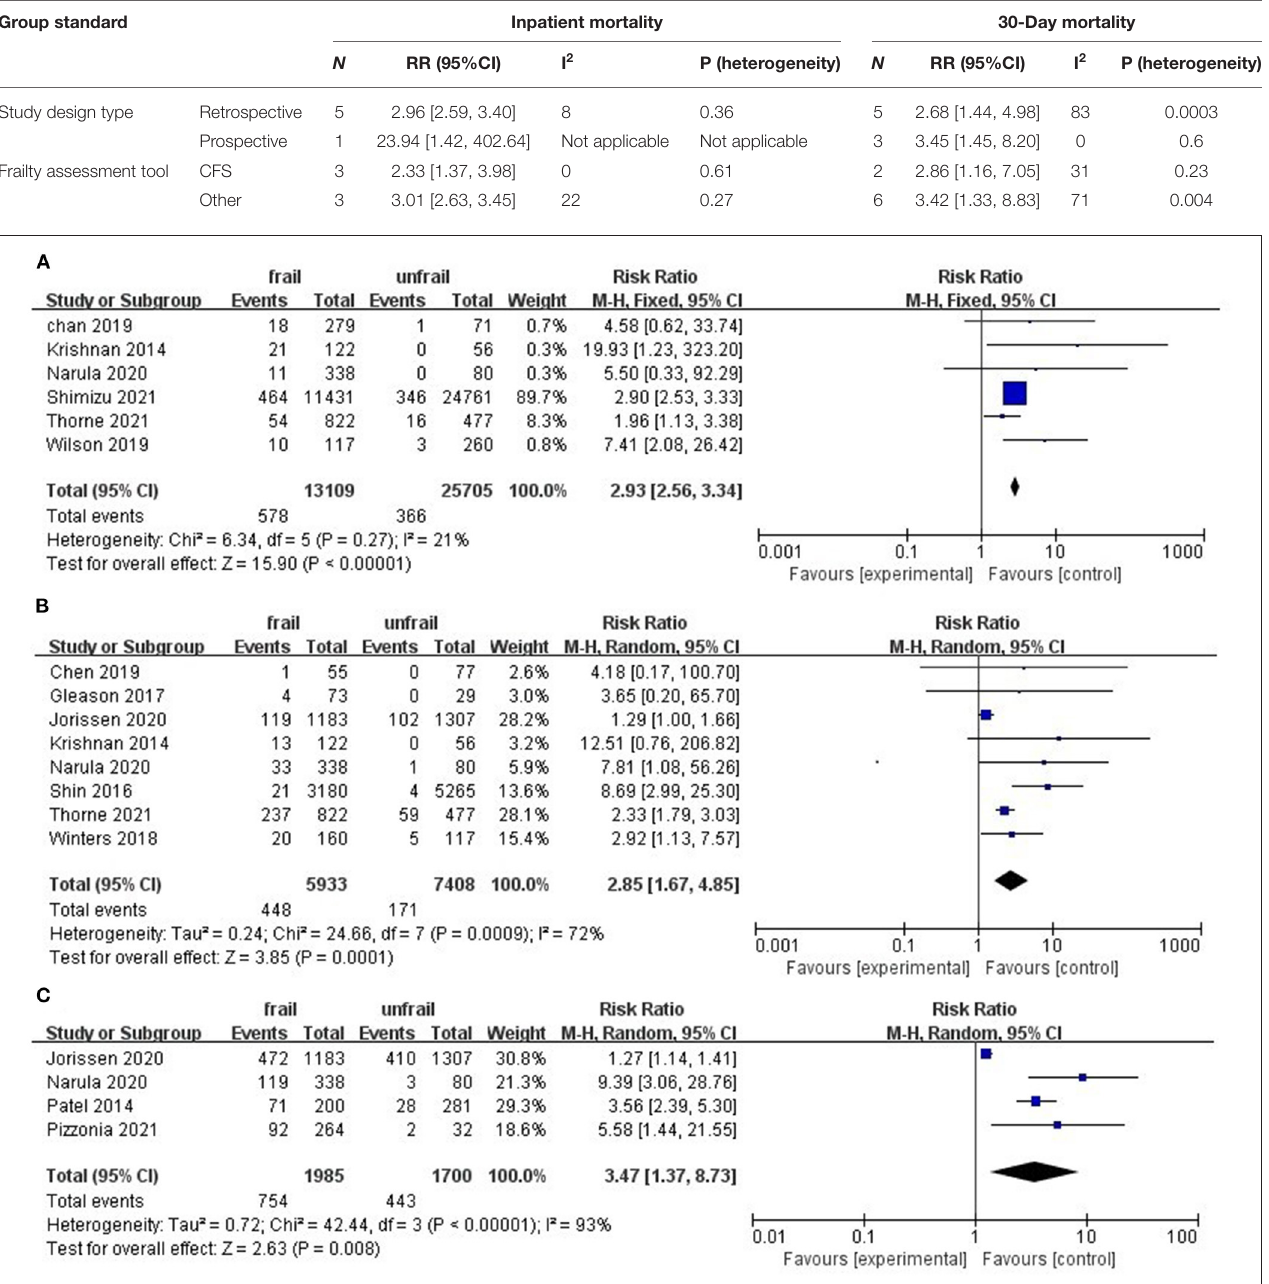
TABLE 2 | Subgroup analysis of frailty associated with mortality in patients with hip fracture. Group standard